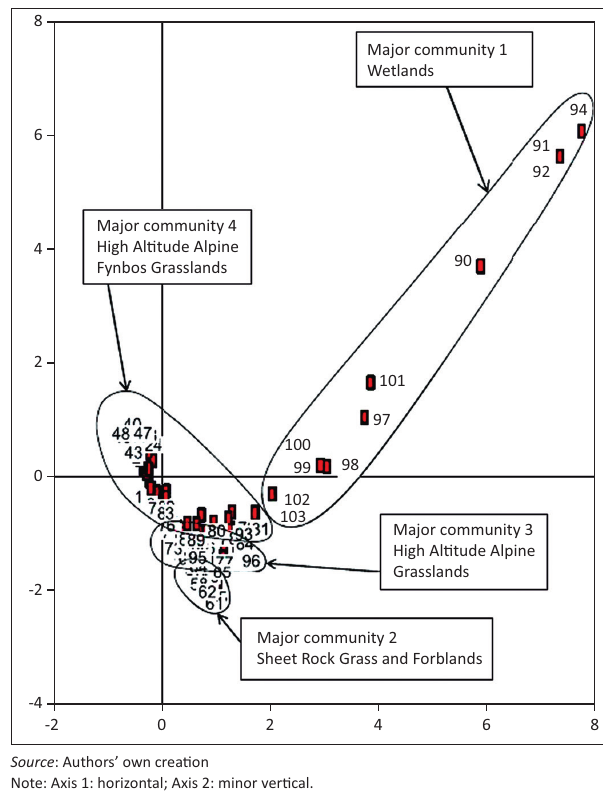
FIGURE 4: Correspondence analysis of all relevés showing major communities 1, 2, 3 and